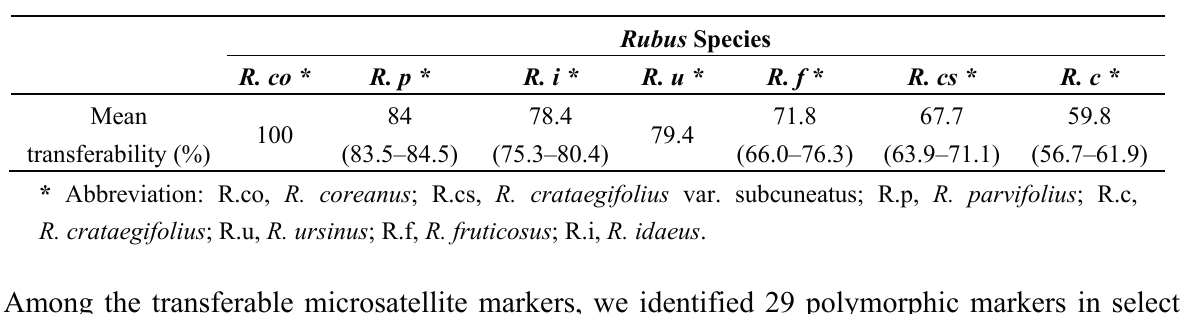
Table 2. Transferability of 97 new microsatellite markers within the Rubus